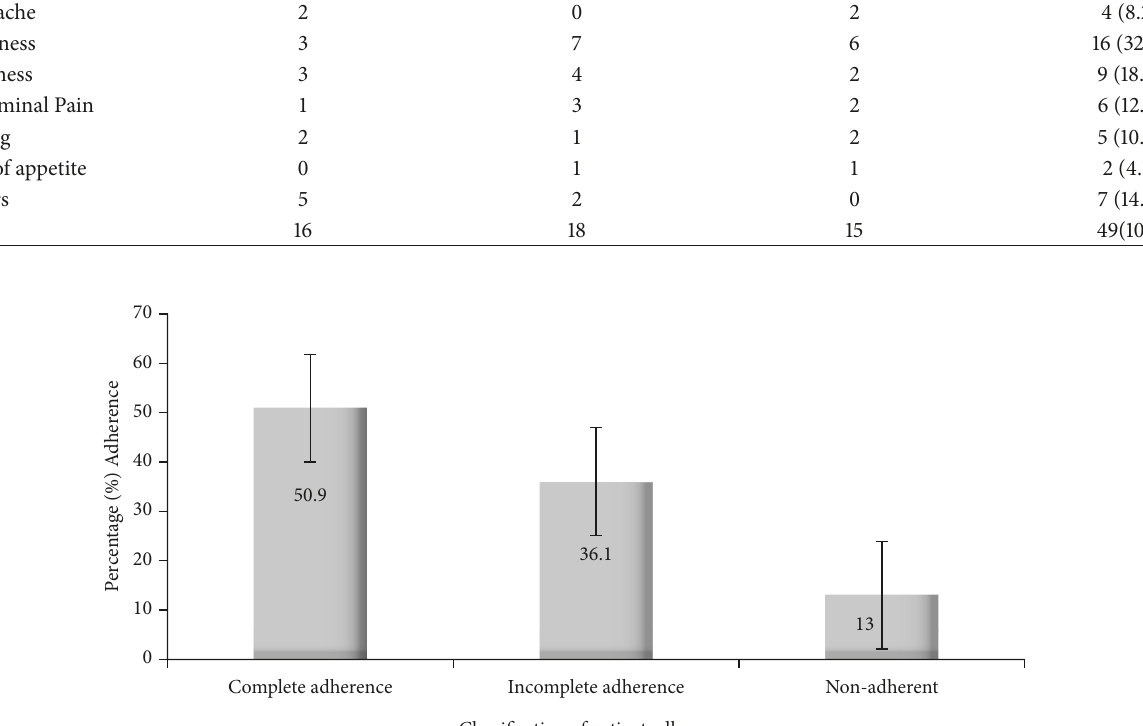
12.2% (6/49), itching, 10.2% (5/49), headache, 8.2%